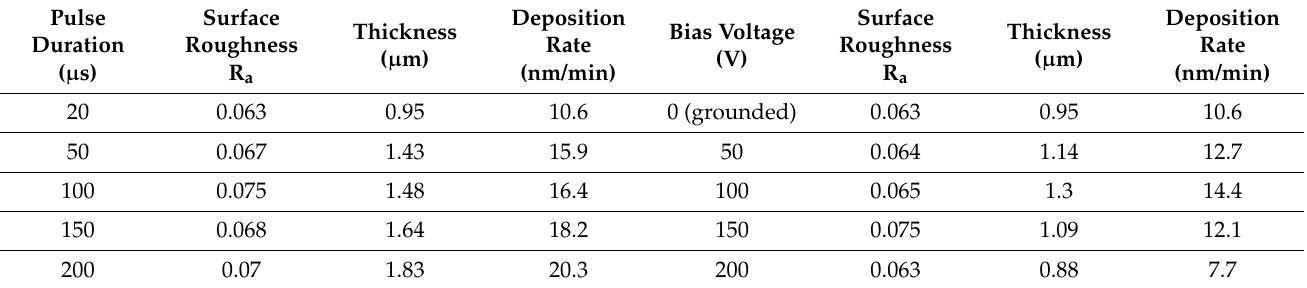
Table 2. Surface roughness, thickness, and deposition rates of the